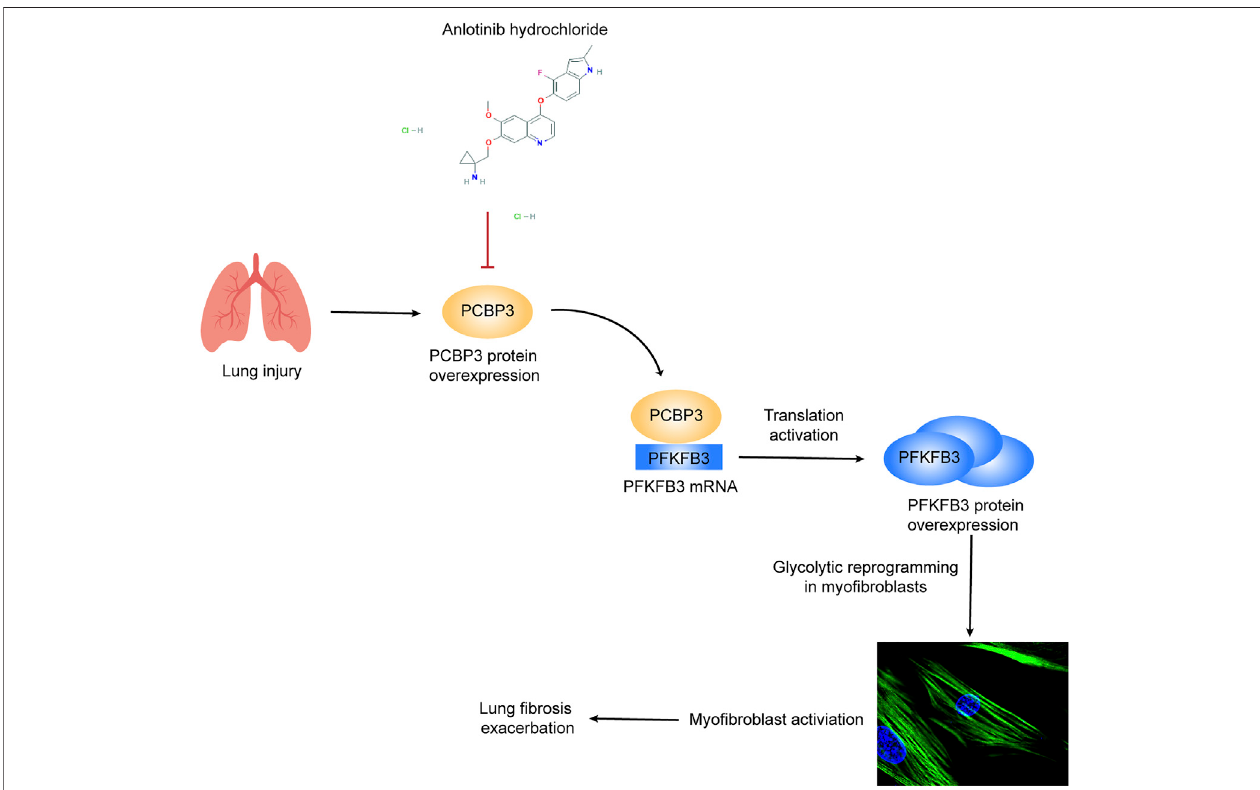
FIGURE 8 | Schematic representation of PCBP3-PFKFB3-dependent glycolysis and the inhibitory effect of anlotinib on this pathway. Lung injury induces PCBP3 expression, which results in an increase in PFKFB3 expression by promoting its translation, resulting in the augmentation of glycolysis in lung fi broblasts. Glycolytic reprogramming participates in myo fi broblast activation and furthers lung fi brosis. The tyrosine kinase inhibitor anlotinib inhibits PFKFB3-driven glycolysis by decreasing the expression of PCBP3, thereby suppressing myo fi broblast activation and inhibiting the exacerbation of lung fi brosis.